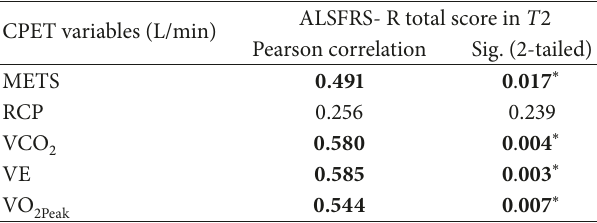
Table 5: Correlations between ALSFRS-R total score and CPET variables on the peak of effort at T 2.